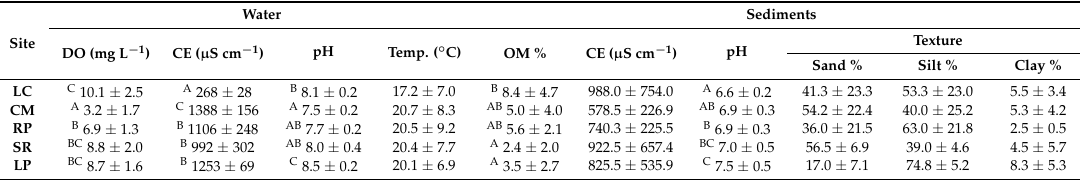
Table 2. Water quality parameters measured in situ and sediment chemical characteristics at each sampling site on the Suqu í a River basin (mean ± standard deviation). Different letters, when indicated, represent significant differences between monitoring stations ( p <